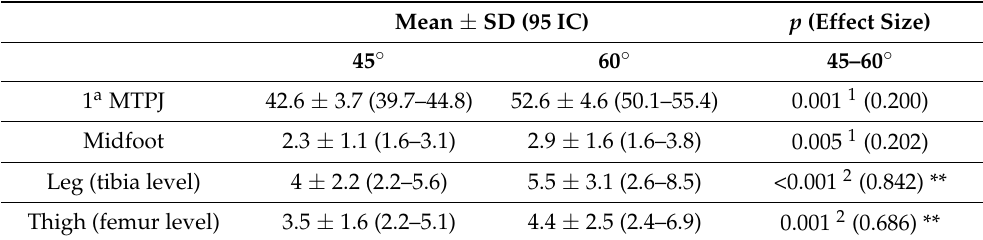
Table 3. Analysis of the evolution of the variables in the inertial sensor system. 1 Student’s t -test for related samples. 2 Wilcoxon test. ** Large effect size. 1 a :